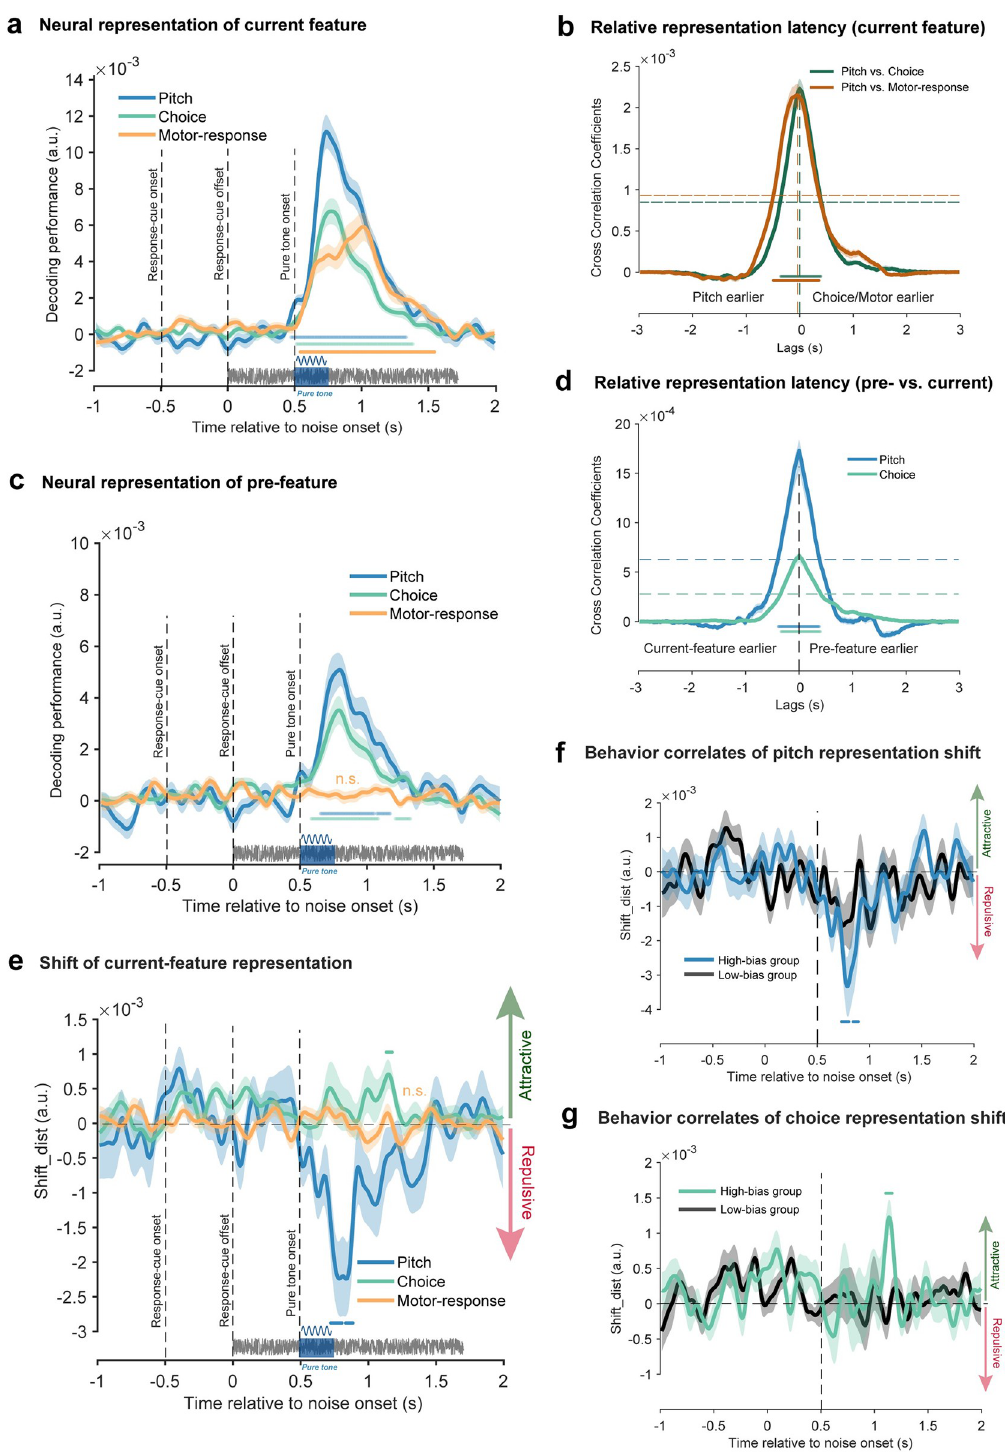
Fig 5. Neural results of Experiment 2. (A) Grand average decoding performance for current-trial features as a function of time following the sustained white noise, for pitch (blue), category choice (green), and motor response (orange). Note that the response–cue frame occurred before white noise onset ( − 0.5 s, dashed vertical line). Time 0 denotes the white noise onset. Vertical dashed lines from left to right denote the onset and offset of response–cue frame, and the pure tone onset, respectively. Horizontal colored lines denote significant temporal clusters (cluster-based permutation test, p < 0.05, one-sided,